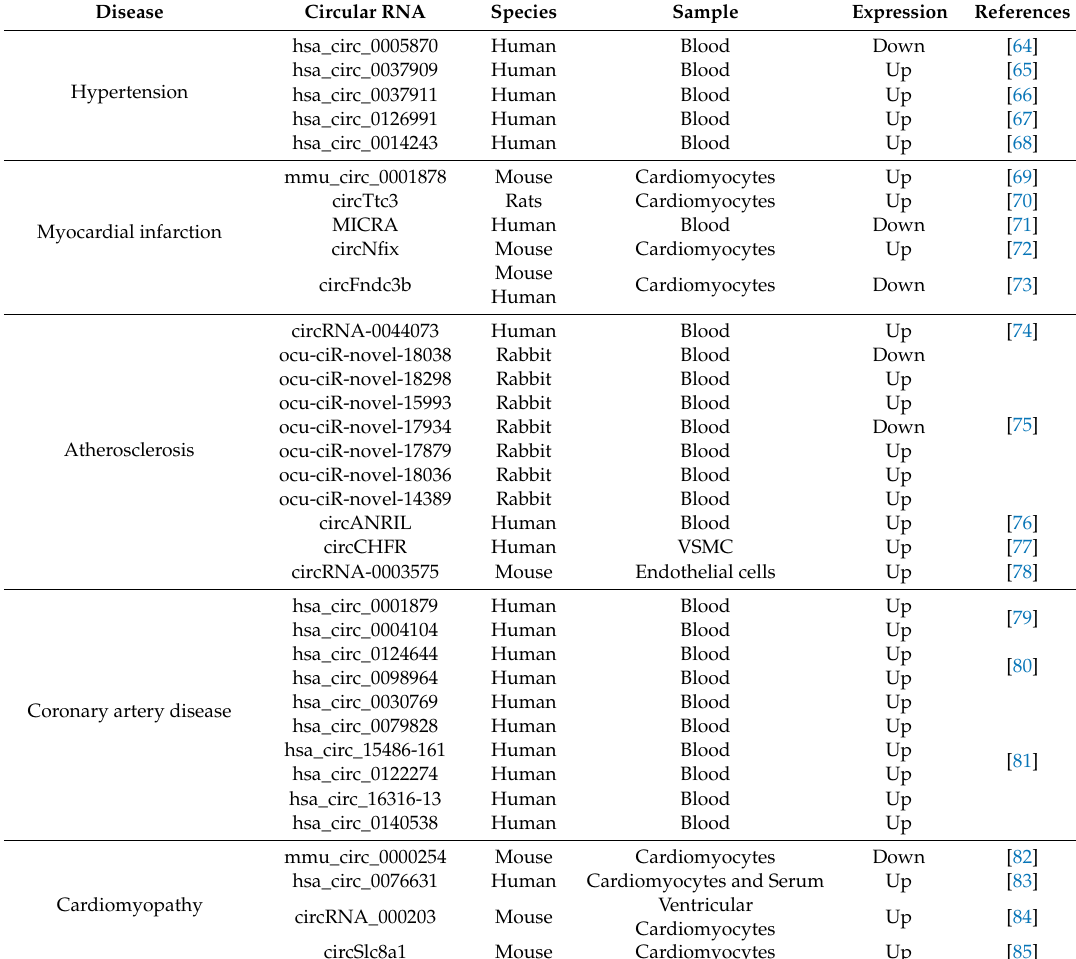
Table 1. Summary of circRNAs implicated in cardiovascular diseases, including species and sample types studied and di ff erential expression